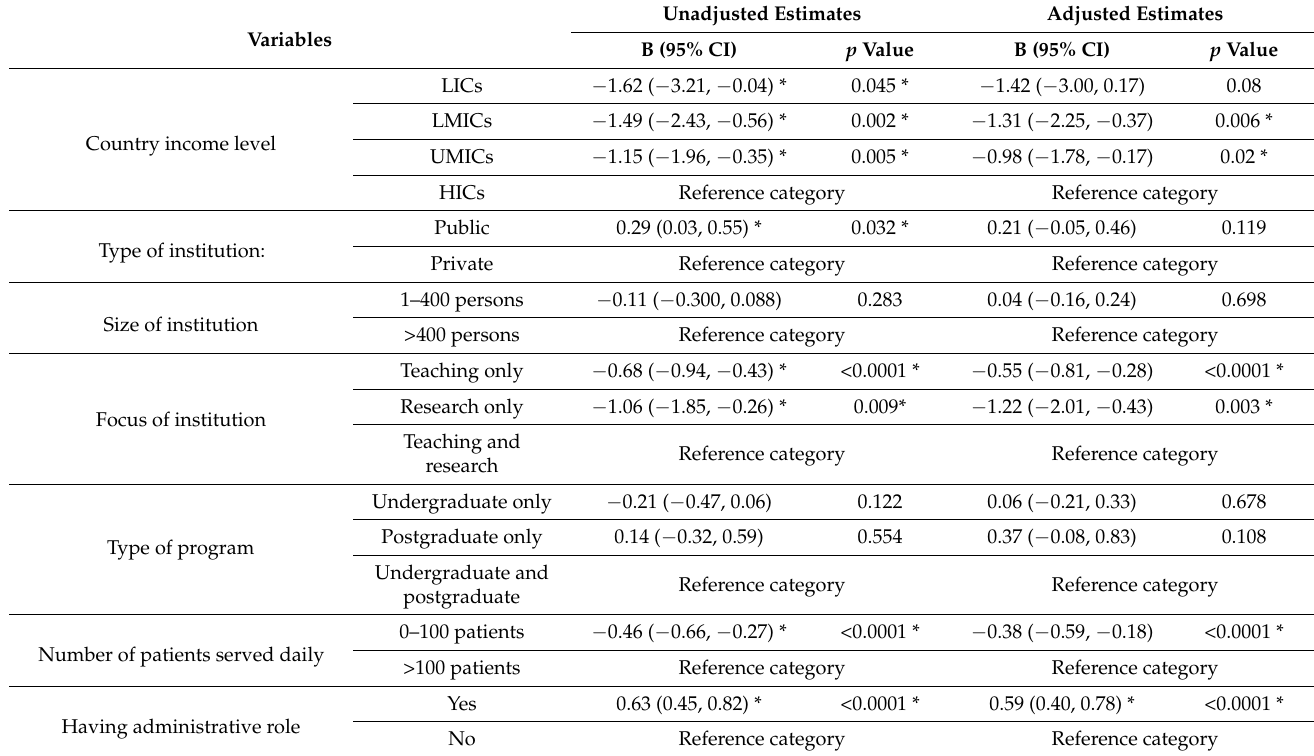
Table 3. Multilevel linear regression analysis for factors affecting overall perceived preparedness in dental academic